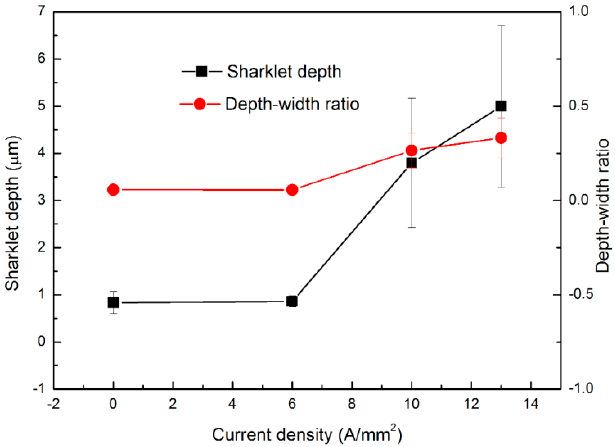
Figure 9. Variations in sharklet depth and depth–width ratio for different current densities.